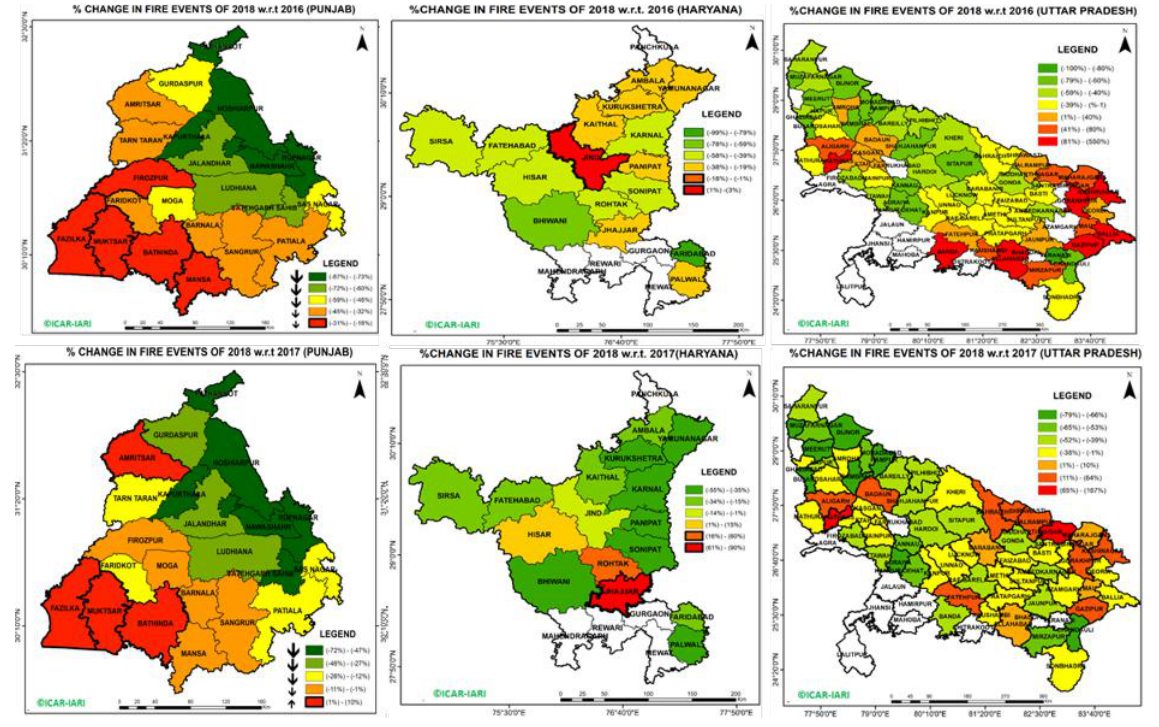
Figure 10. District-wise percentage change in fire count of 2018 with respect to 2017 and 2016 for Punjab, Haryana and UP.